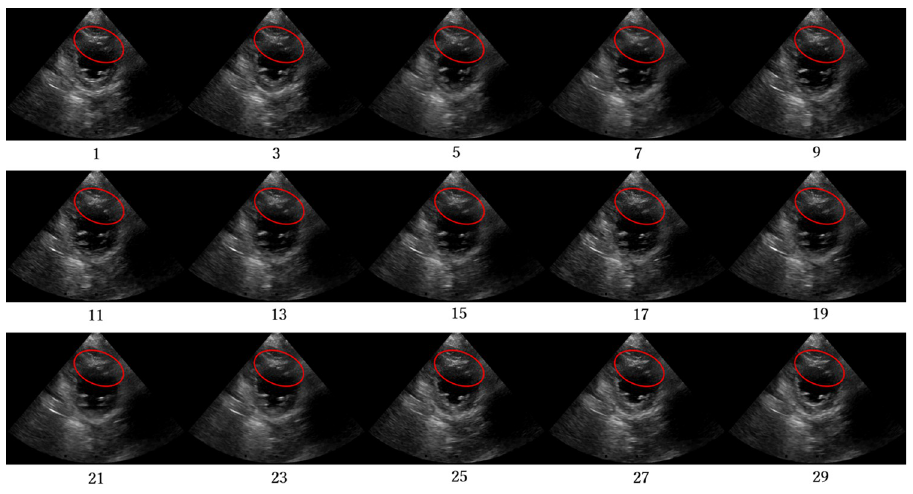
Fig 23. True-positive cases on short-axis view papillary muscle level images.